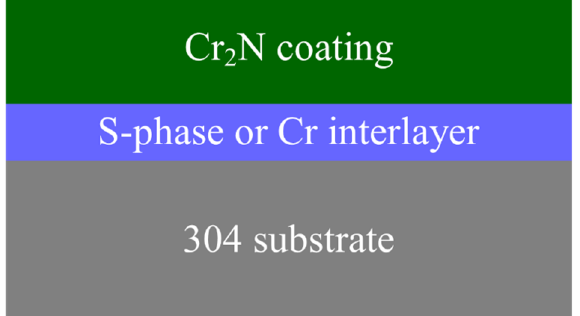
Figure 1. Schematic structure of composite coating deposited in experiments [44].